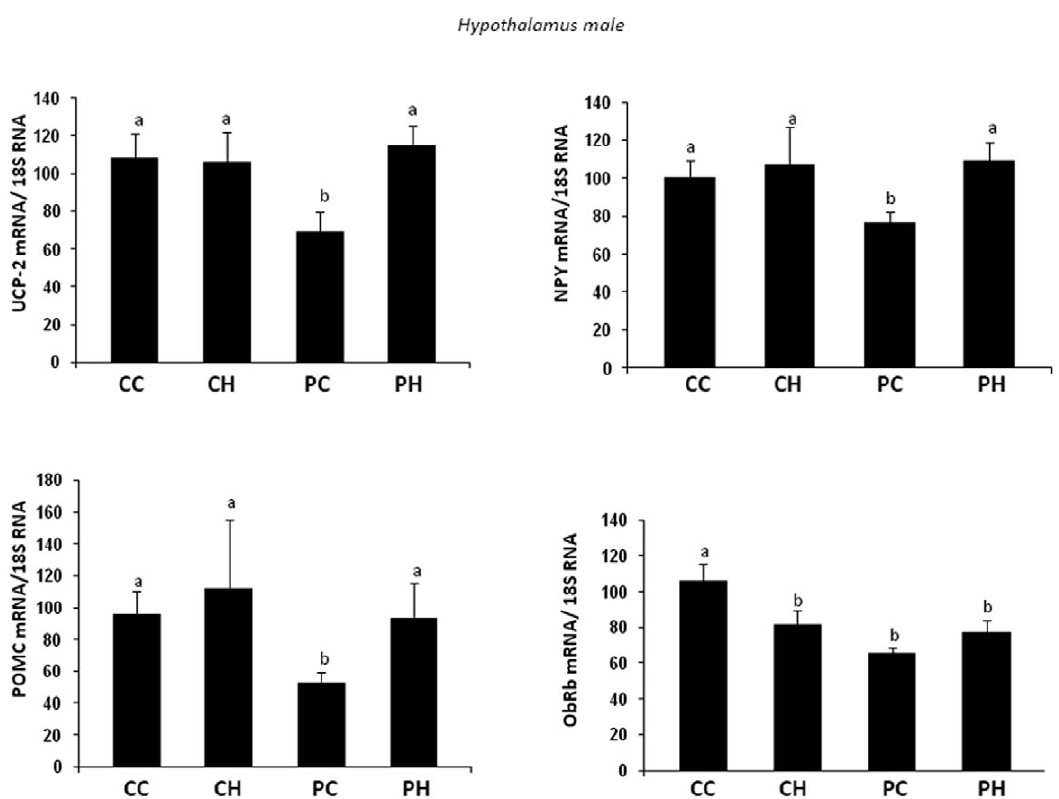
Figure 7. Impact of post weaning diet on hypothalamic gene expression of male pups born to dams fed the control diet (C) or high- fat diet (HF). At weaning offspring were divided into four groups of each gender (CC, CH, PC, PH; n=10) and named according to the post weaning diet (C or P, first letter) and to maternal diet (C or H, second letter). From weaning to 7 weeks of age all groups were assigned to chow diet then swithched to C or P diet for 13 additional weeks. UCP-2, NPY, POMC and ObRb expression were measured by quantitative RT-PCR and results were normalized to 18S RNA. Different superscript letters a,b denote significant differences at p , 0.05 by ANOVA and the Fisher posthoc test.